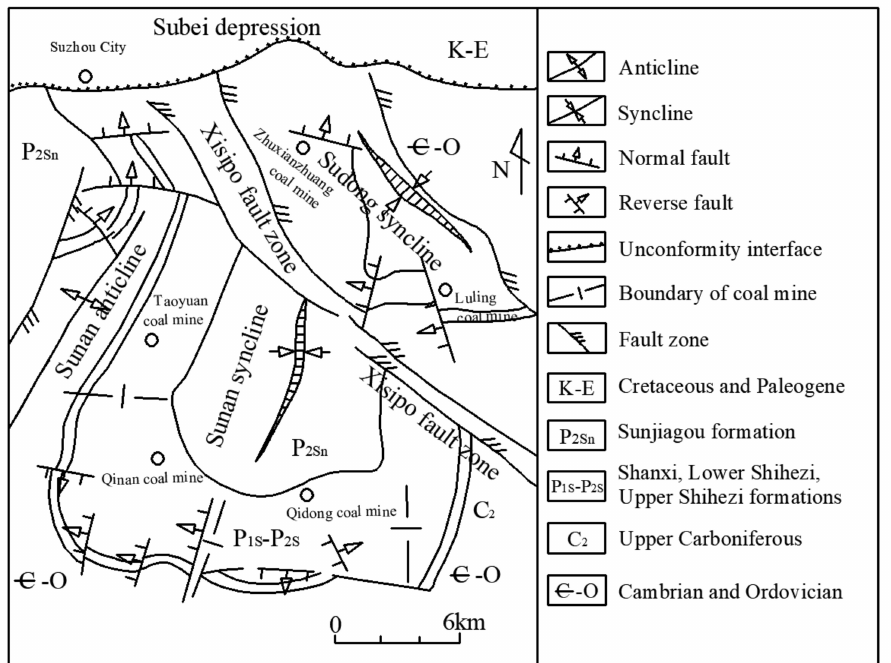
Figure 4. Tectonic outline map in the Suxian mining area. Modified from